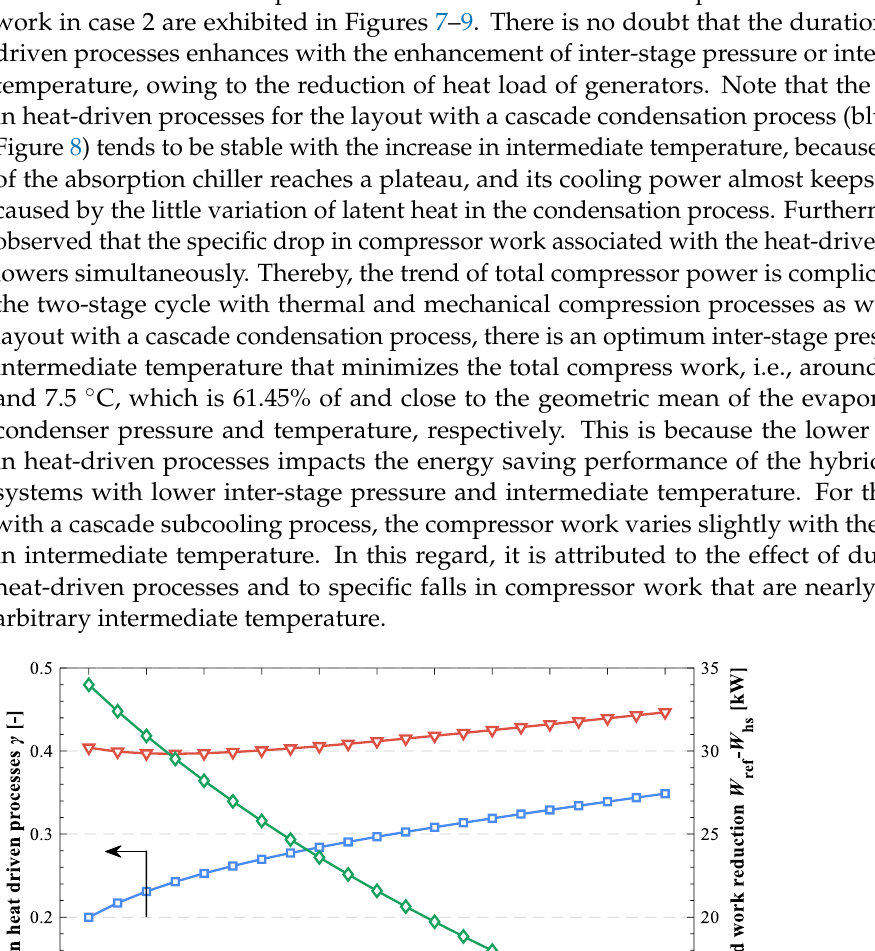
Figure 8. Effect of inter-stage pressure for the layout with a cascade condensation process in case 2.